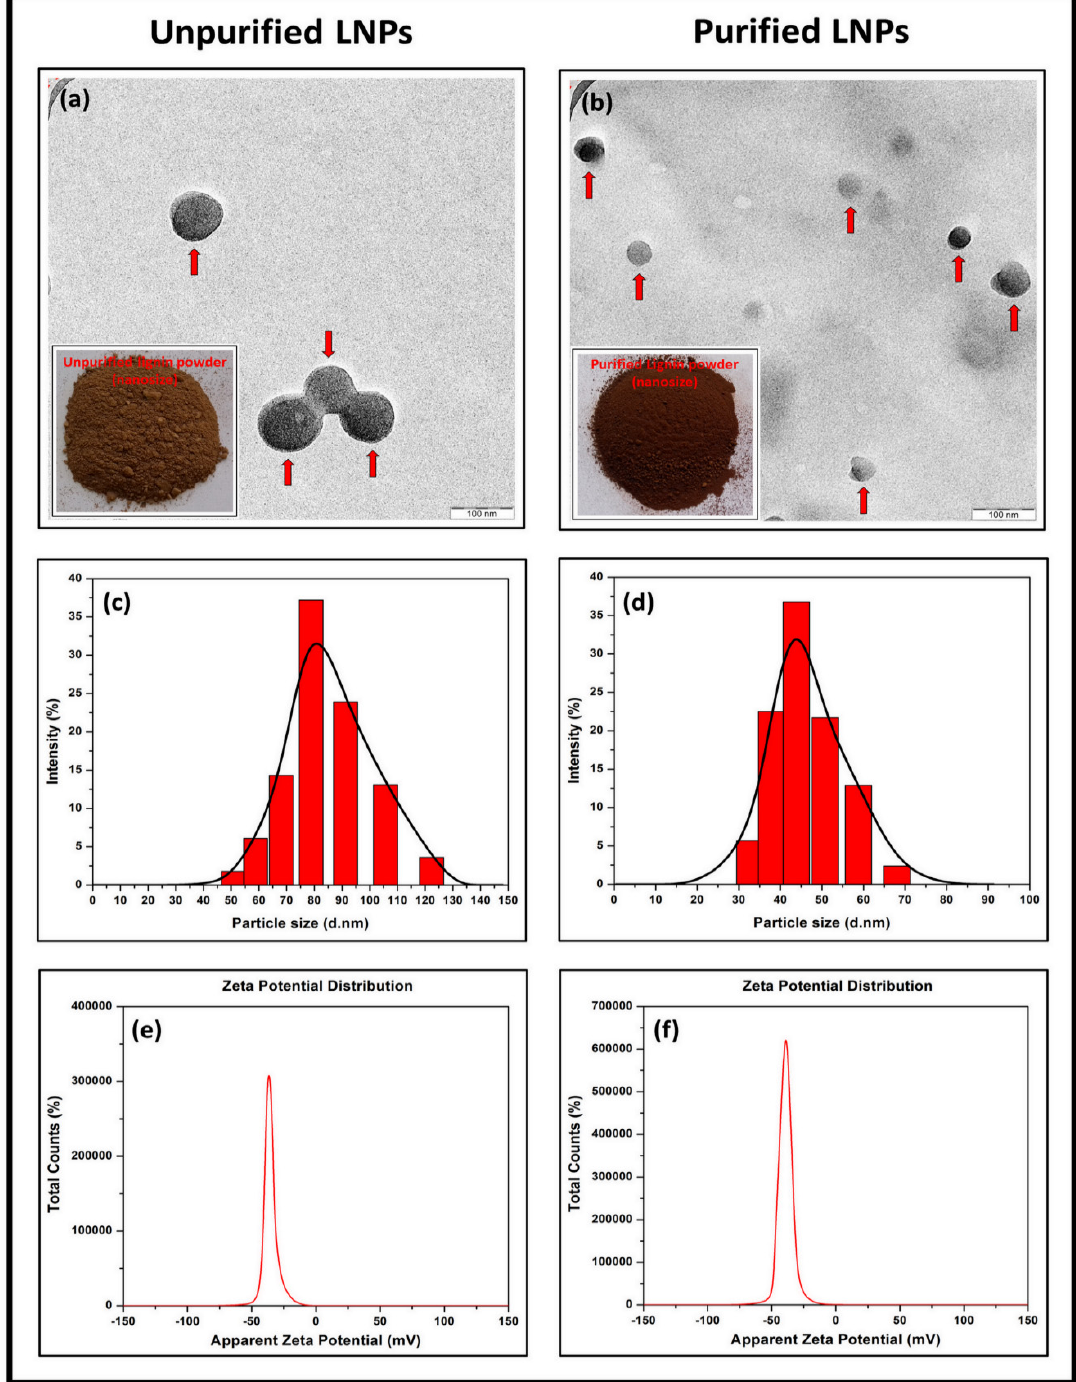
Figure 1. TEM micrograph and nanosized lignin powder (inset figure) of ( a ) unpurified lignin nanoparticles (LNPs) and ( b ) purified LNPs, particle size distribution of ( c ) unpurified LNPs ( d ) purified LNPs, zeta potential distribution of ( e ) unpurified LNPs and ( f ) purified LNPs.